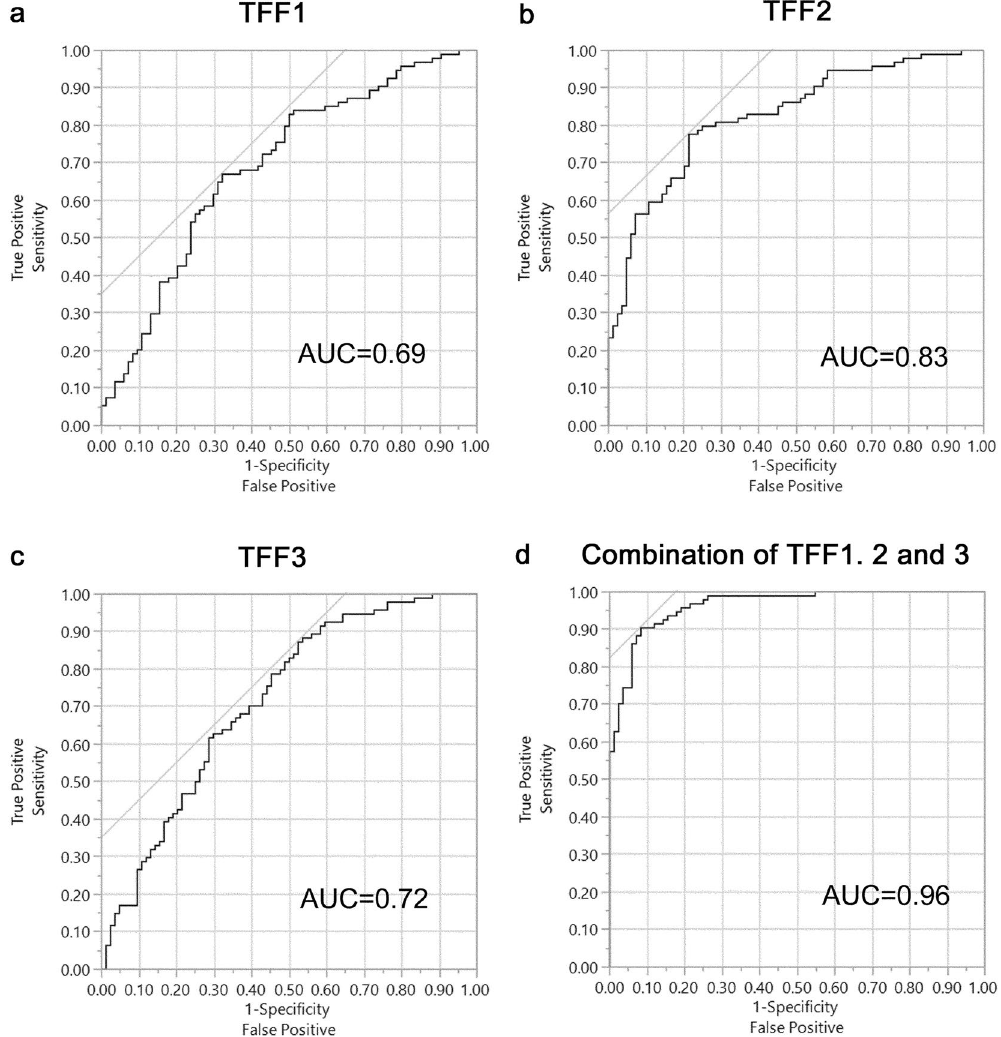
TFF1, TFF2 and TFF3 was 0.69, 0.83 and 0.72. The AUC of the combination of TFF1, TFF2, and TFF3 was